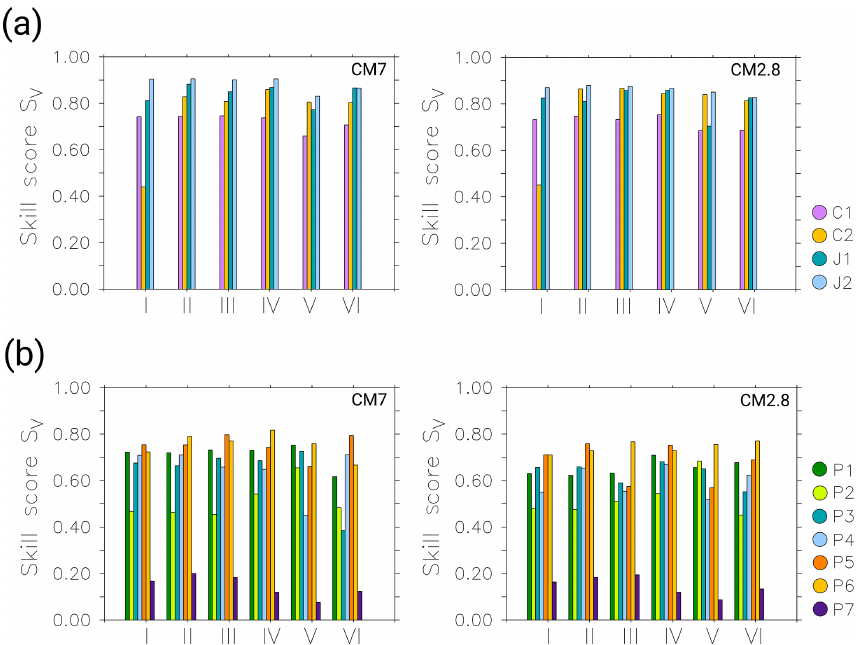
Figure 15. The bar plots show the calculated skill scores S V for the comparison of forecast days one to six (horizontal axis) to the obser- vations. The colours refer to the different observations. Panel (a) displays the results for C1, C2, J1 and J2. Panel (b ) shows the results for P1–P7. The CM7 and CM2.8 results are shown on the left and right side, respectively.